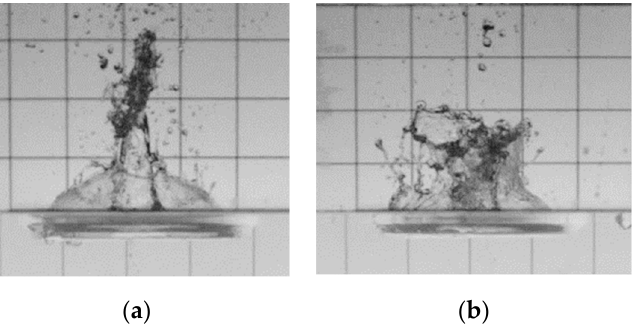
Figure 17. The splash diagram of the hydrophobic model at the initial velocity v = 3.95 m/s. ( a ) The semi-spherical splash in the case of a hemispherical angle of 0°. ( b ) Splashes break in the case of a hemispherical angle of 57°.